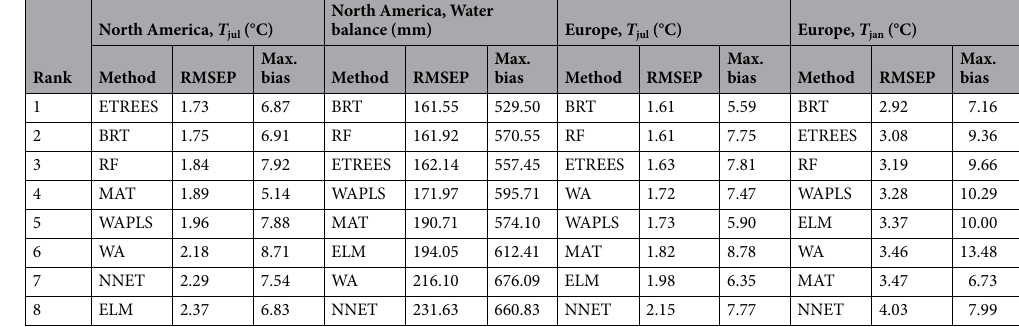
Table 3. Cross-validated performance metrics for the individual pollen–climate calibration models. Results are shown for eight models and for primary and secondary climate variables in each calibration dataset (North America and Europe), using h- block cross-validation with h determined by the variogram-range method. The metrics shown for each model are root-mean-square error of prediction (RMSEP) and maximum (Max.) bias. Models are ranked based on increasing